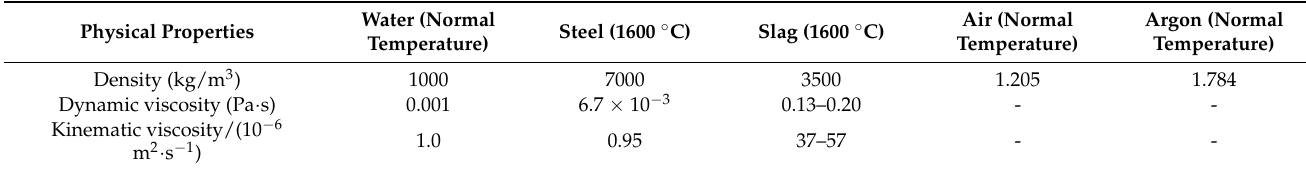
Table 2. Physical properties of various substances [26].